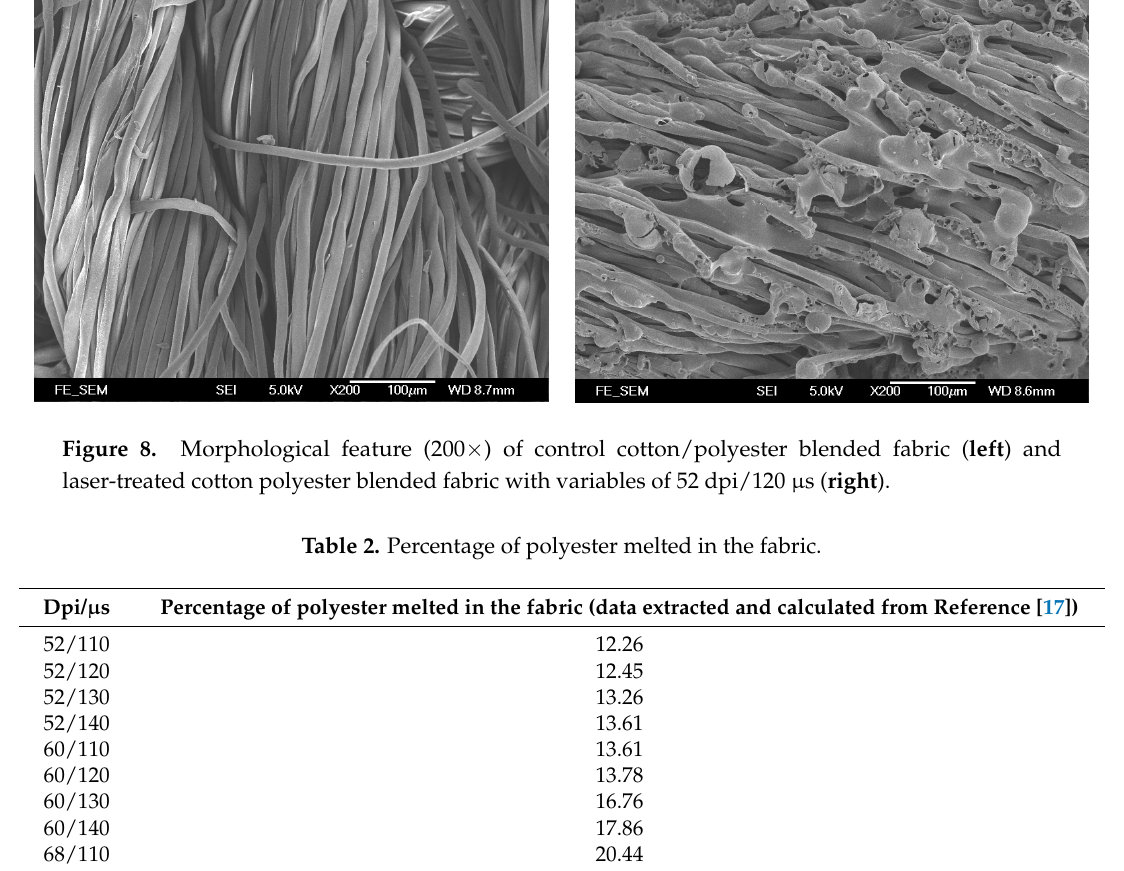
Figure 7. Relationship between laser processing variables and the stiffness of cotton/polyester blended fabric.